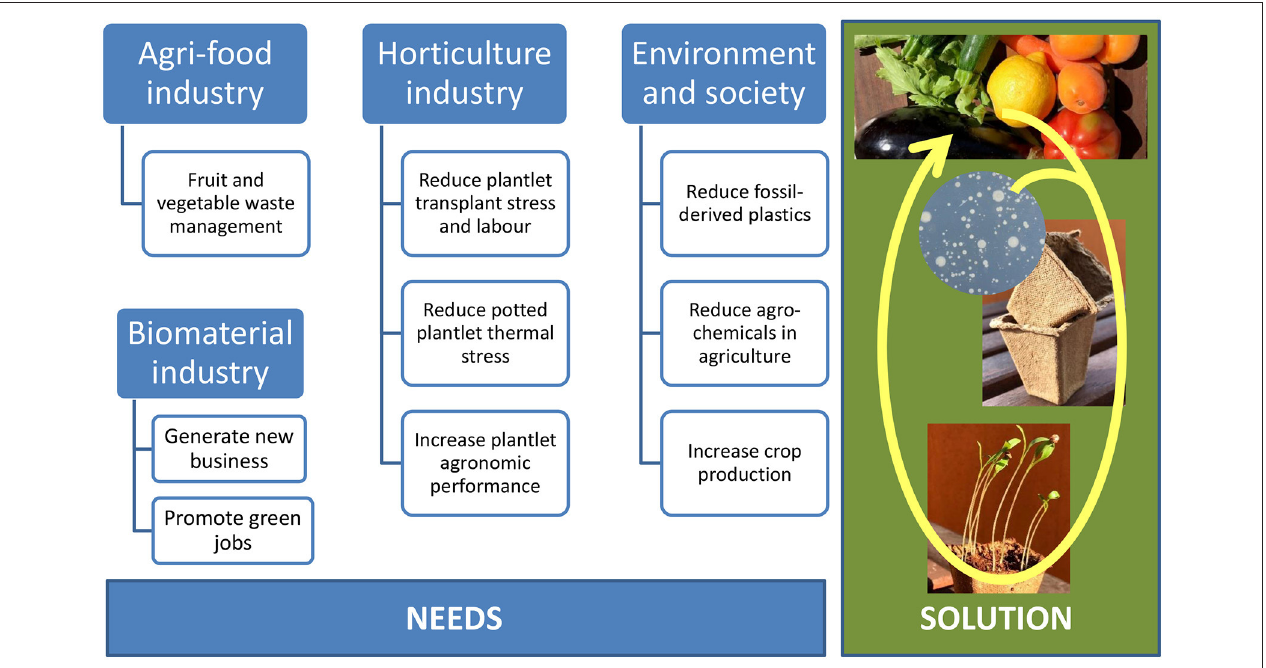
FIGURE 1 | Food waste-derived biomaterials enriched by biostimulant agents have the potential to respond to multiple needs in a circular